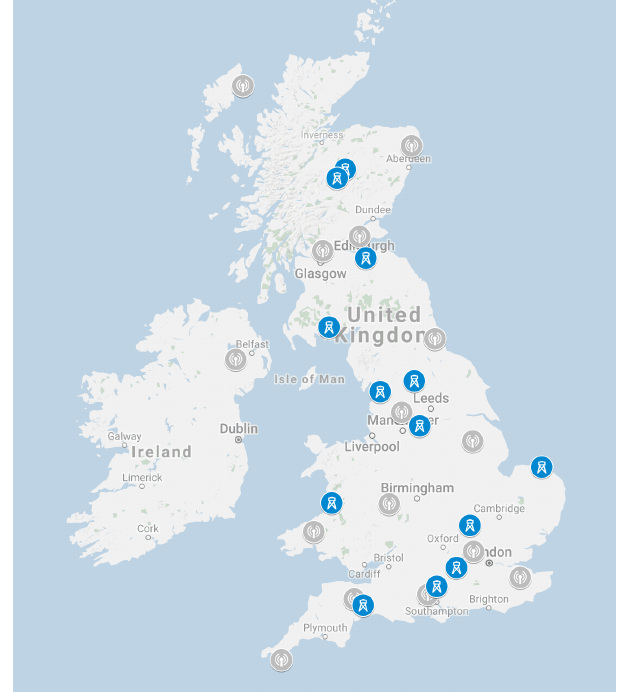
Figure 3. Instrument locations that make up the Disdrometer Ver- ification Network (DiVeN) as of September 2018. Grey icons are the operational Met Office radars as well as the Met Office re- search radar at Wardon Hill. Map data © 2018 GeoBasis-DE/BKG (© 2009), Google, Inst. Geogr.